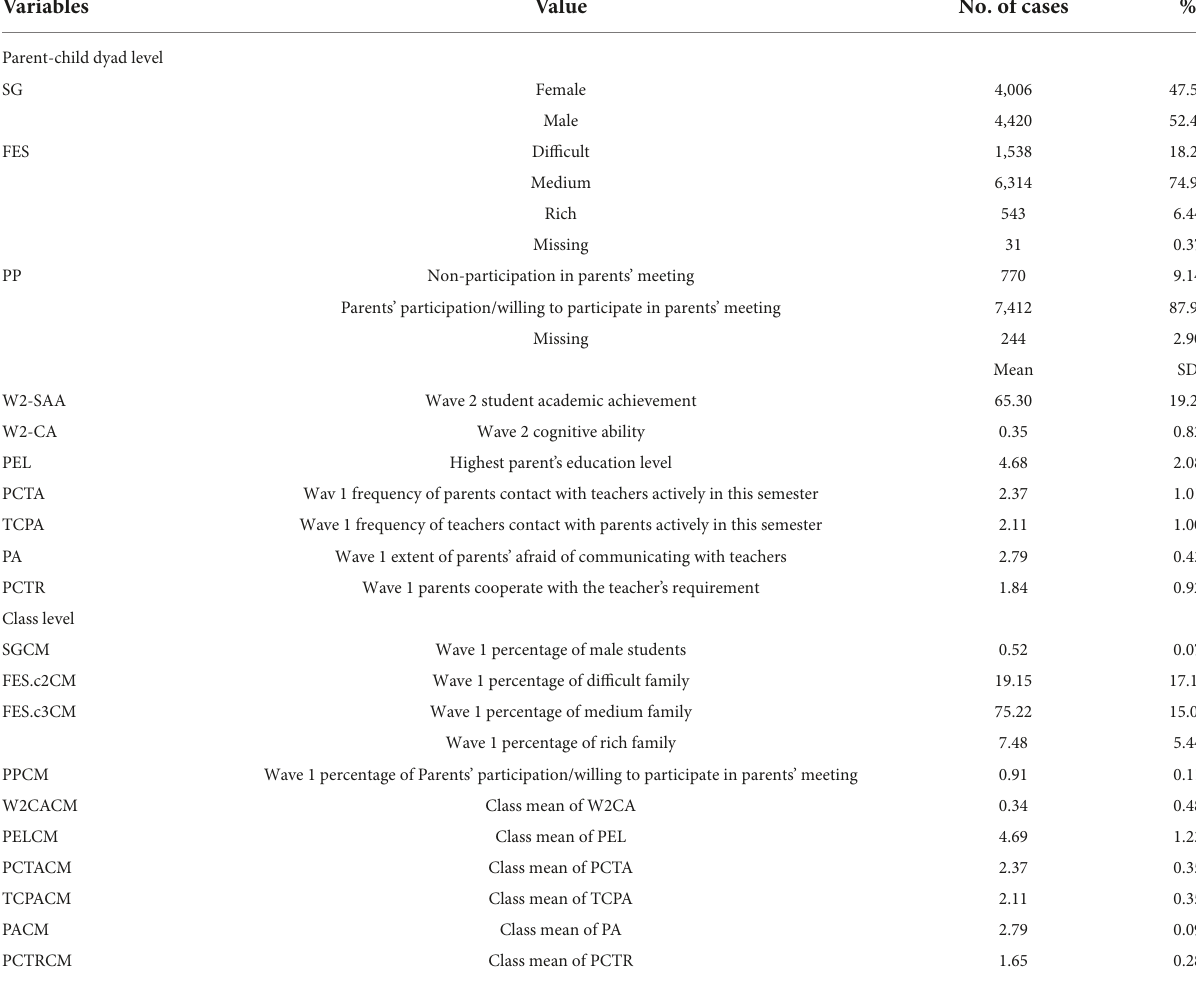
TABLE 2 Description statistics of 8,426 child and